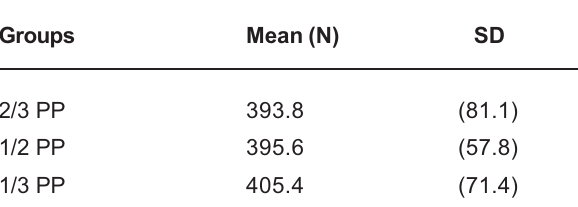
TABLE 1- Resistance to failure values of test specimens, means (N) of test groups and standard deviations